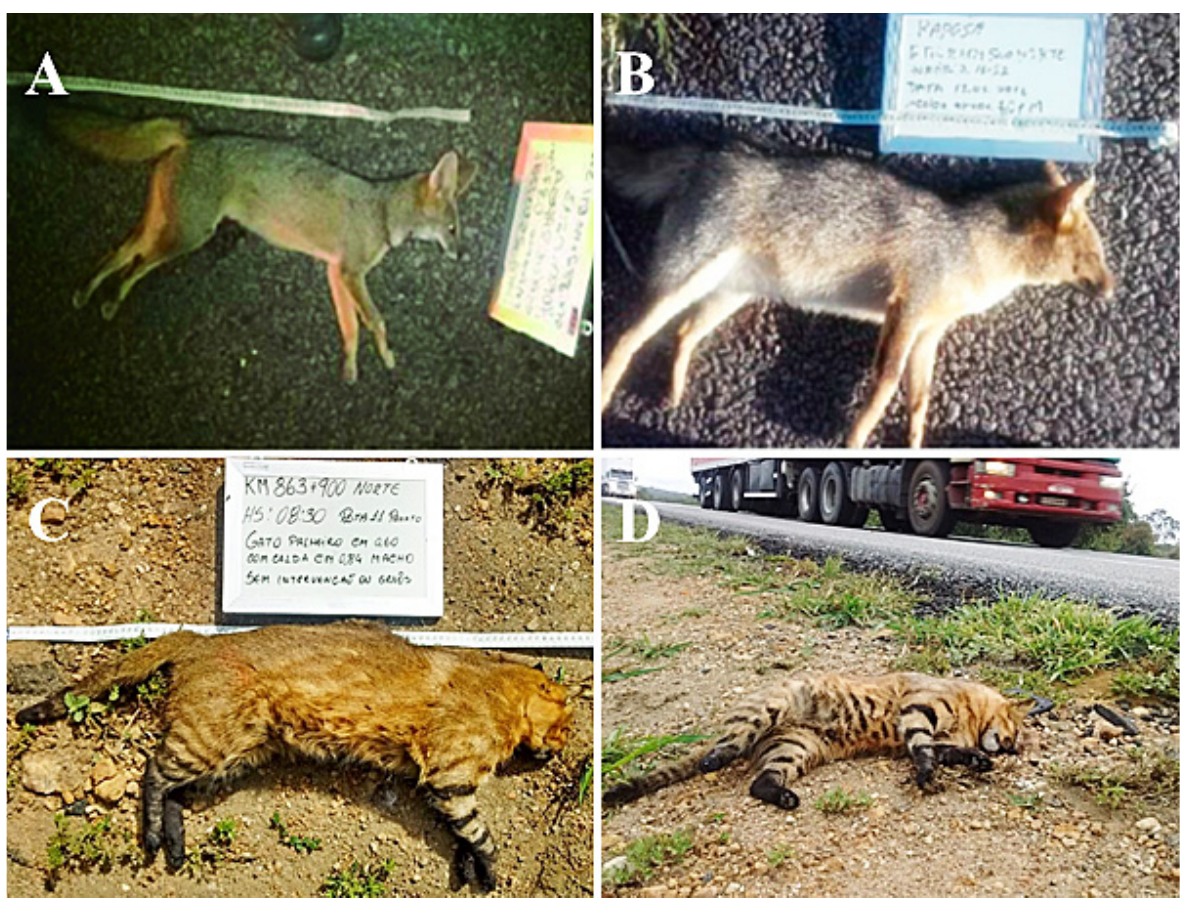
Figure 2. Three roadkilled specimens along BR-116 highway (Vitória da Conquista, Bahia). A. Lycalopex vetulus (adult, unknown sex). B. L. vetulus (adult, unknown sex). C, D. Leopardus braccatus (adult male), same individual taken from different angles. Photographs by the Via Bahia toll maintenance